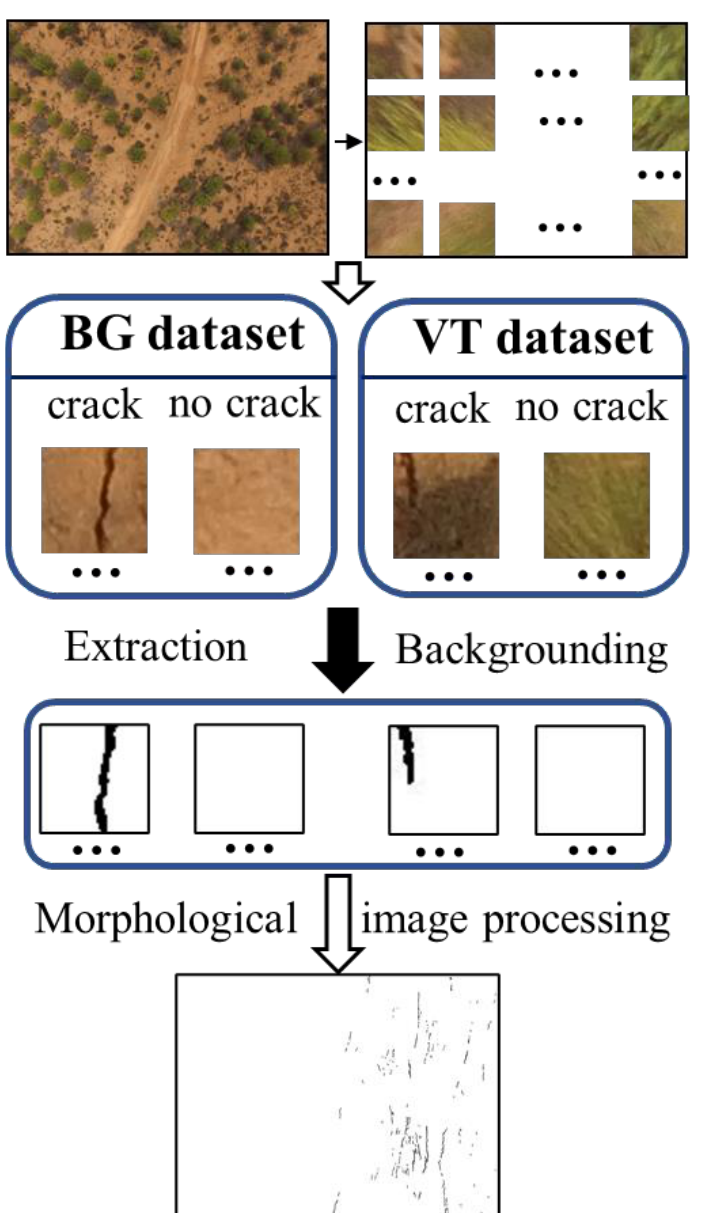
Figure 3. The steps of the crack extraction method based on machine learning.